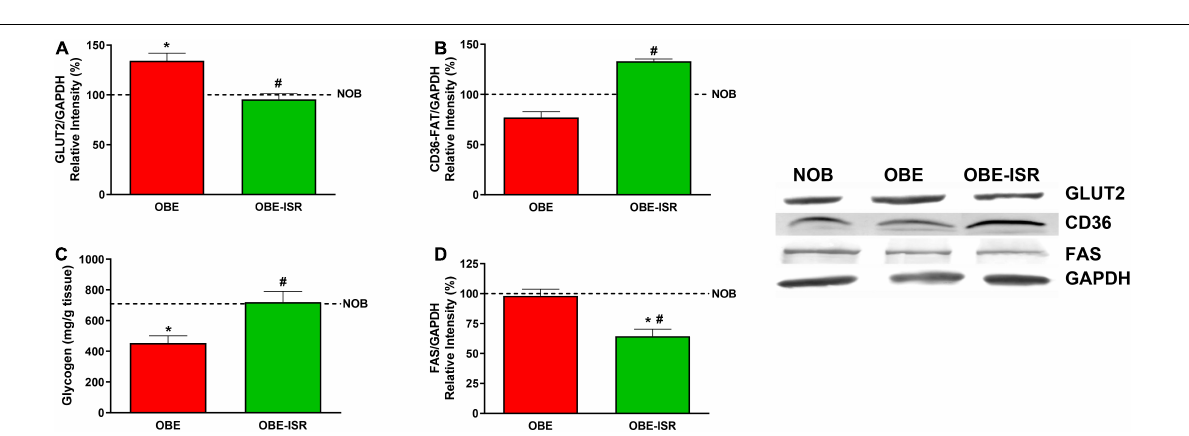
FIGURE 4 | Uptake and storage of metabolic substrates in liver. (A) GLUT2. (B) CD36-FAT. (C) Glycogen. (D) FAS. Rats were fed a normal rodent diet (NOB) or a high-fat diet (HFD) formulated with rapidly (OBE) or with slowly digestible carbohydrates (OBE-ISR). Data expressed as mean ± SEM. *Significant difference with NOB group, p < 0.05. #Significant difference with OBE group, p <